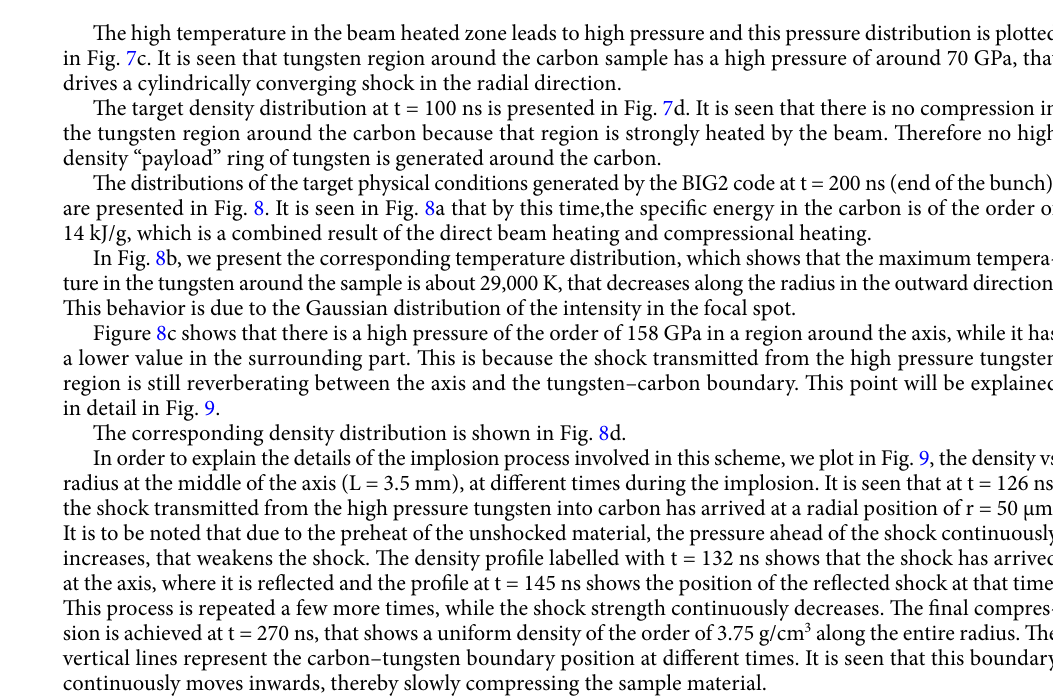
Figure 8. Same as in Fig. 6, but at t = 200 ns (end of the ion